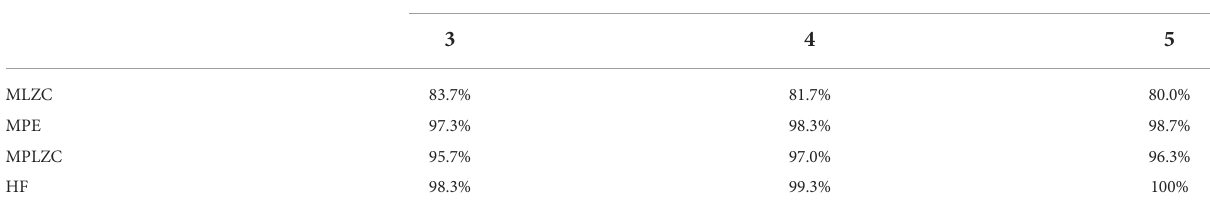
TABLE 3 The highest ARRs of multi-features for six